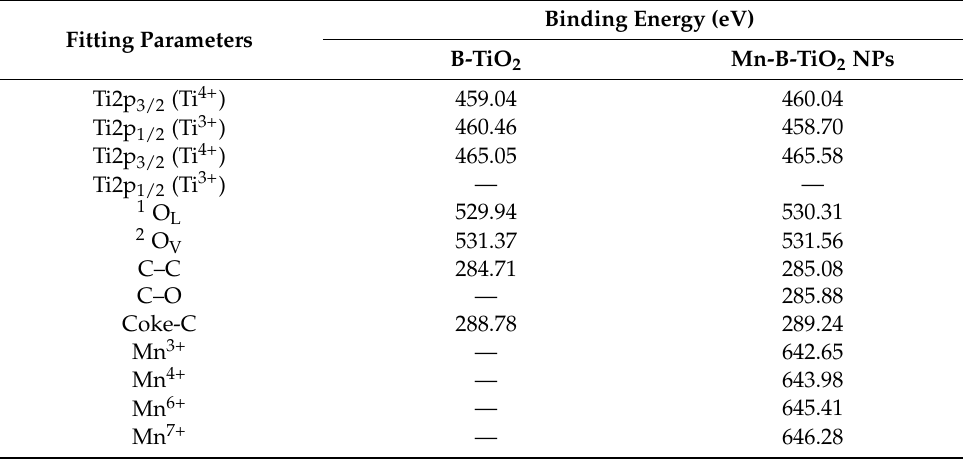
Table 2. XPS fitting parameters for B-TiO 2 and Mn-B-TiO 2